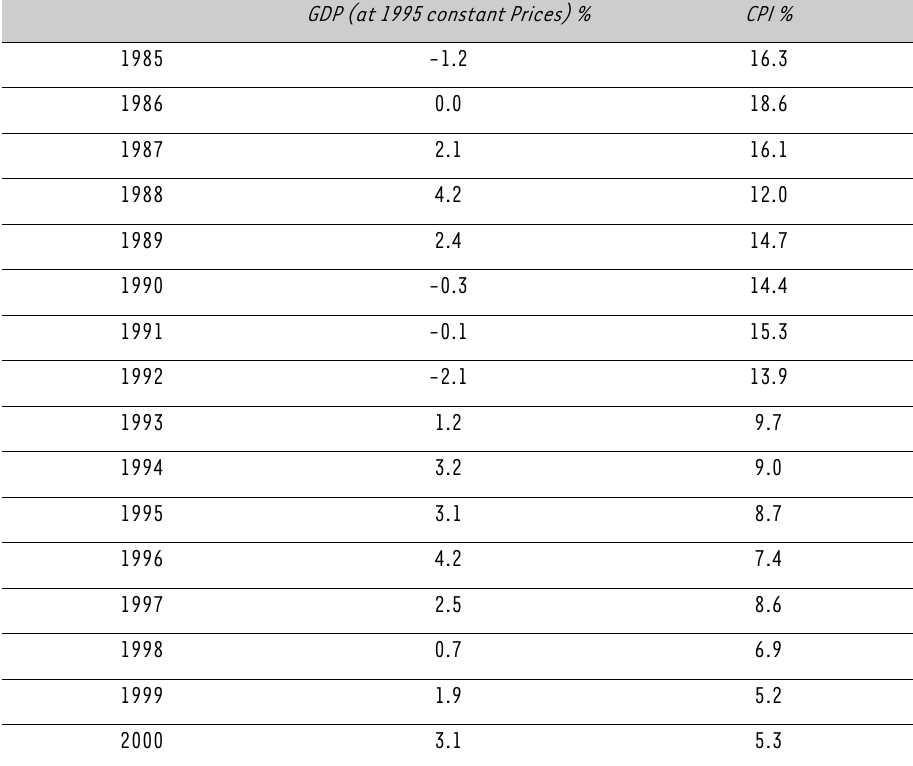
Gross Domestic product (GDP) growth rates and Consumer Price Index, 1985-2000 GDP (at 1995 constant Prices) % CPI % 1985 -1.2